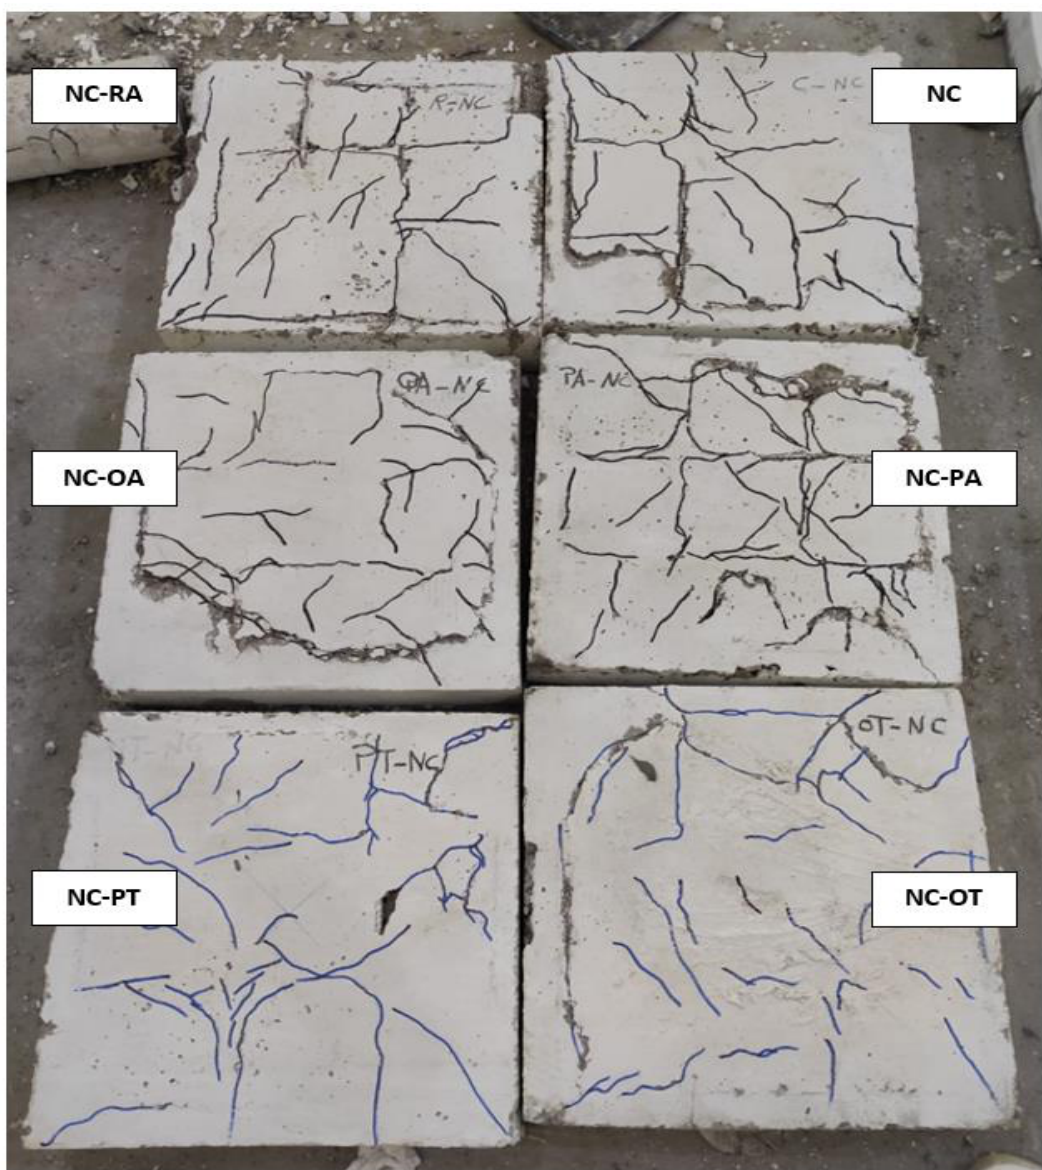
Figure 7. NC specimens cracks.